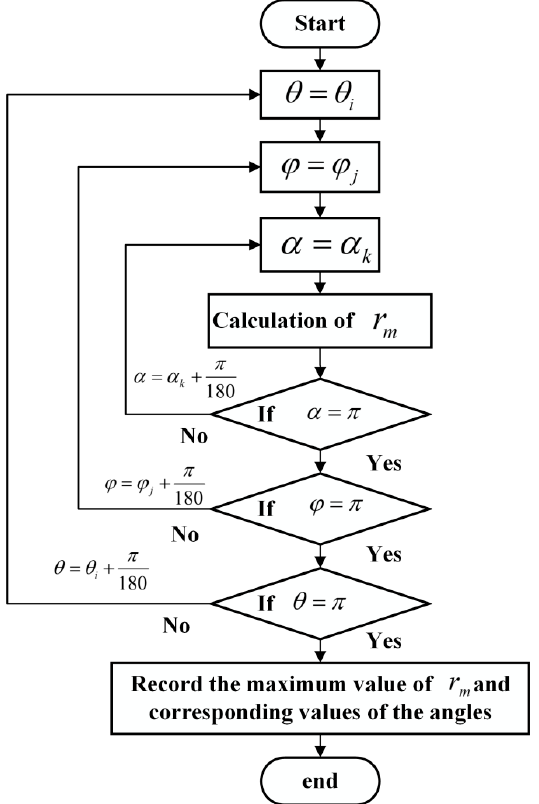
Figure 12. The process of the coordinate transition method.